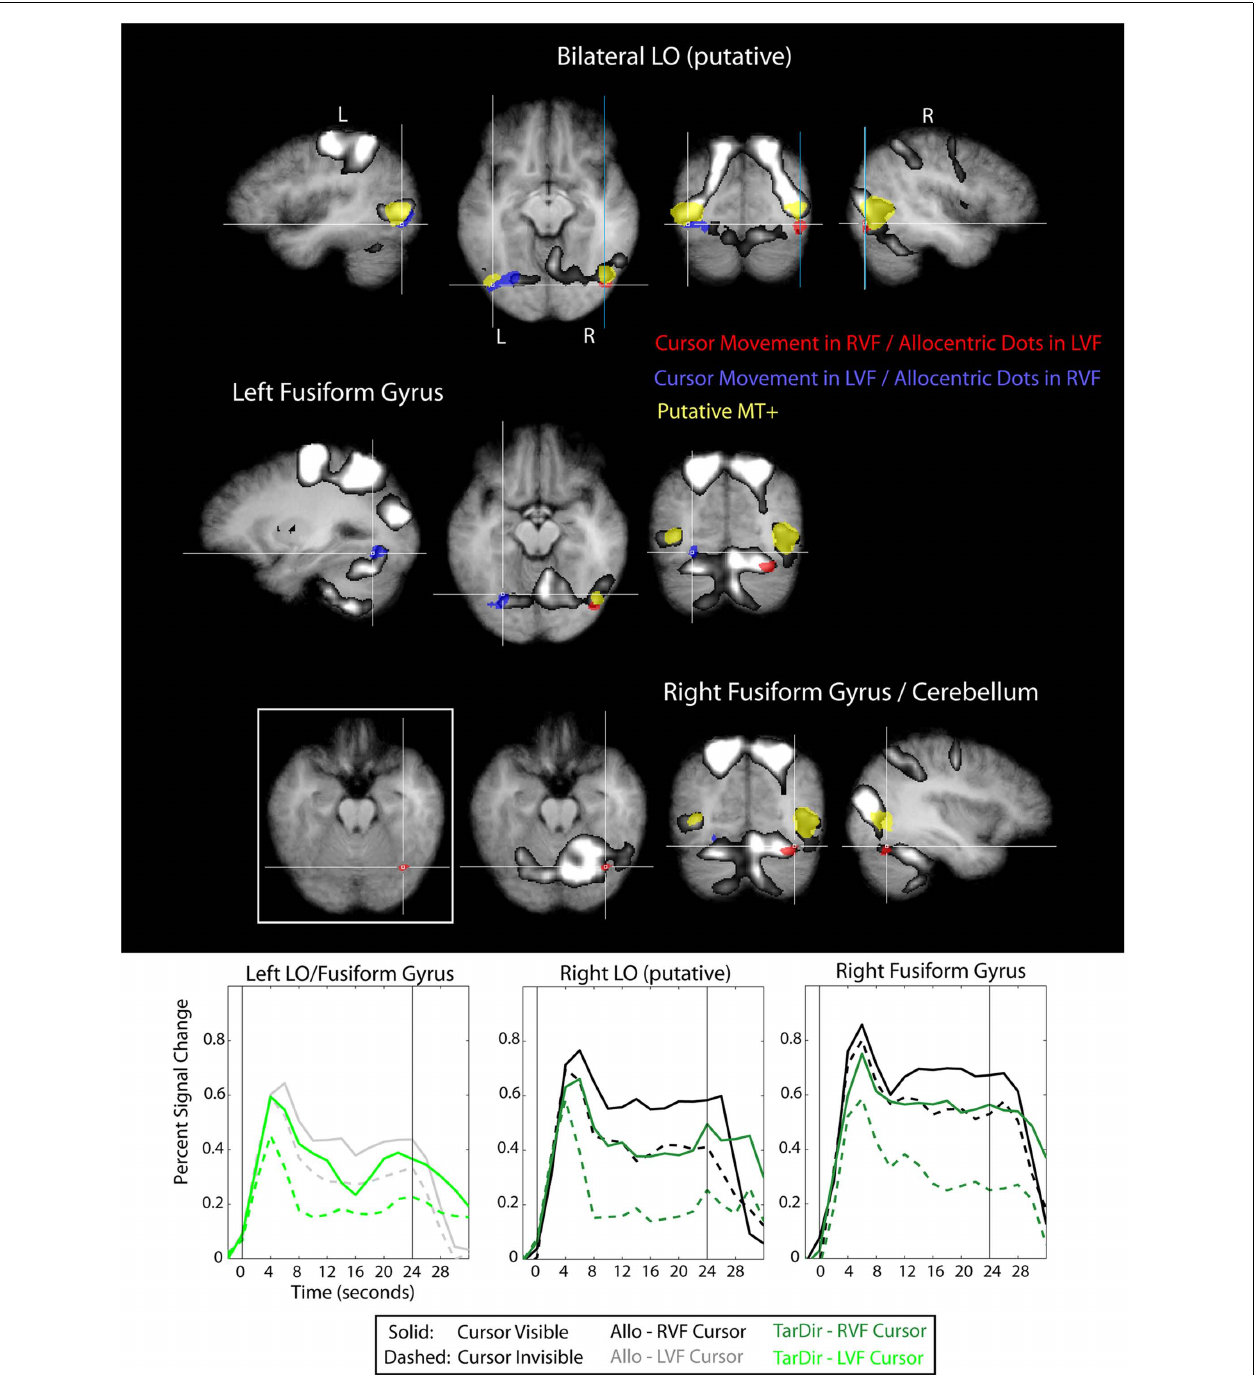
(FFG) and portions of lateral occipital cortex adjacent and posterior to putative visual motion area MT + (putative area LO). For stereotactic coordinates of activation foci see Table 3 . Brain areas in the occipital lobe that are more active during allocentric movements performed in the right or left visual field are denoted in red and blue, respectively. Also shown are “visual feedback areas” (yellow) and the “shared sensory–motor network” (gray).The inset in Figure 8 shows activity without the “shared sensory–motor network” to illustrate the border between cerebellum and activity in inferior occipital cortex. Event related averages of regions depicted in red and blue are shown as